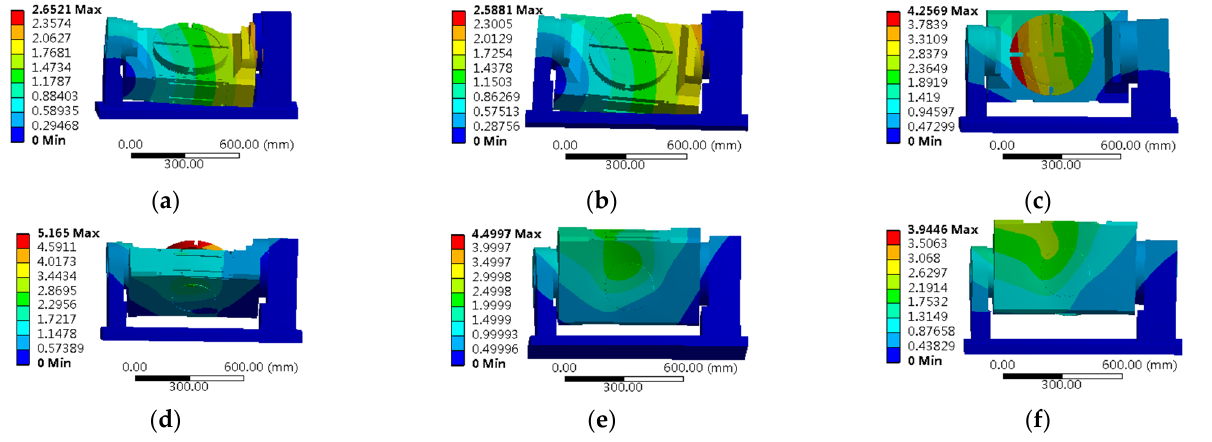
Figure 10. The first mode of the turntable at different swing angles; ( a ) 30°; ( b ) 60°; ( c ) 90°; ( d ) −30°; ( e ) −60°; ( f ) −90°.